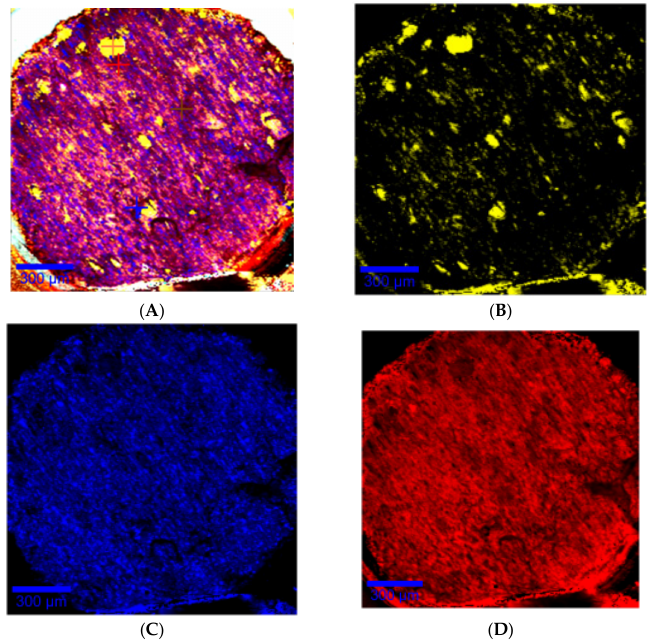
Figure 9. Raman mapping of the slice of a DR2 filament with the representative spectra of the individual compounds at the bottom (yellow: D -sorbitol; blue: amiodarone hydrochloride; red: PEO). Raman mapping is at the top with the same color code indicating the relative presence of the components of the filament with ( A ) all components, ( B ) D -sorbitol, ( C ) amiodarone hydrochloride, ( D ) PEO.